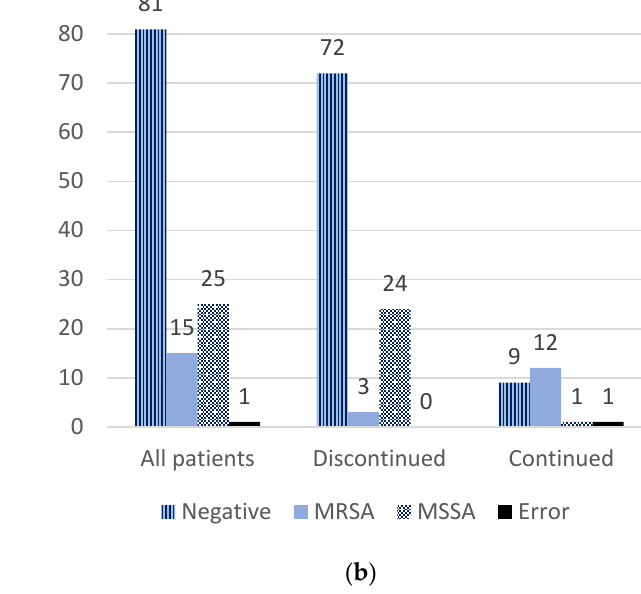
Figure 2. MRSA PCR nasal swab results and responses. ( a ) Provider responses to swab results. Avoided start and stopped therapy collectively form the group of discontinued therapy. ( b ) Provider responses, stratified by result of MRSA PCR nasal swab.